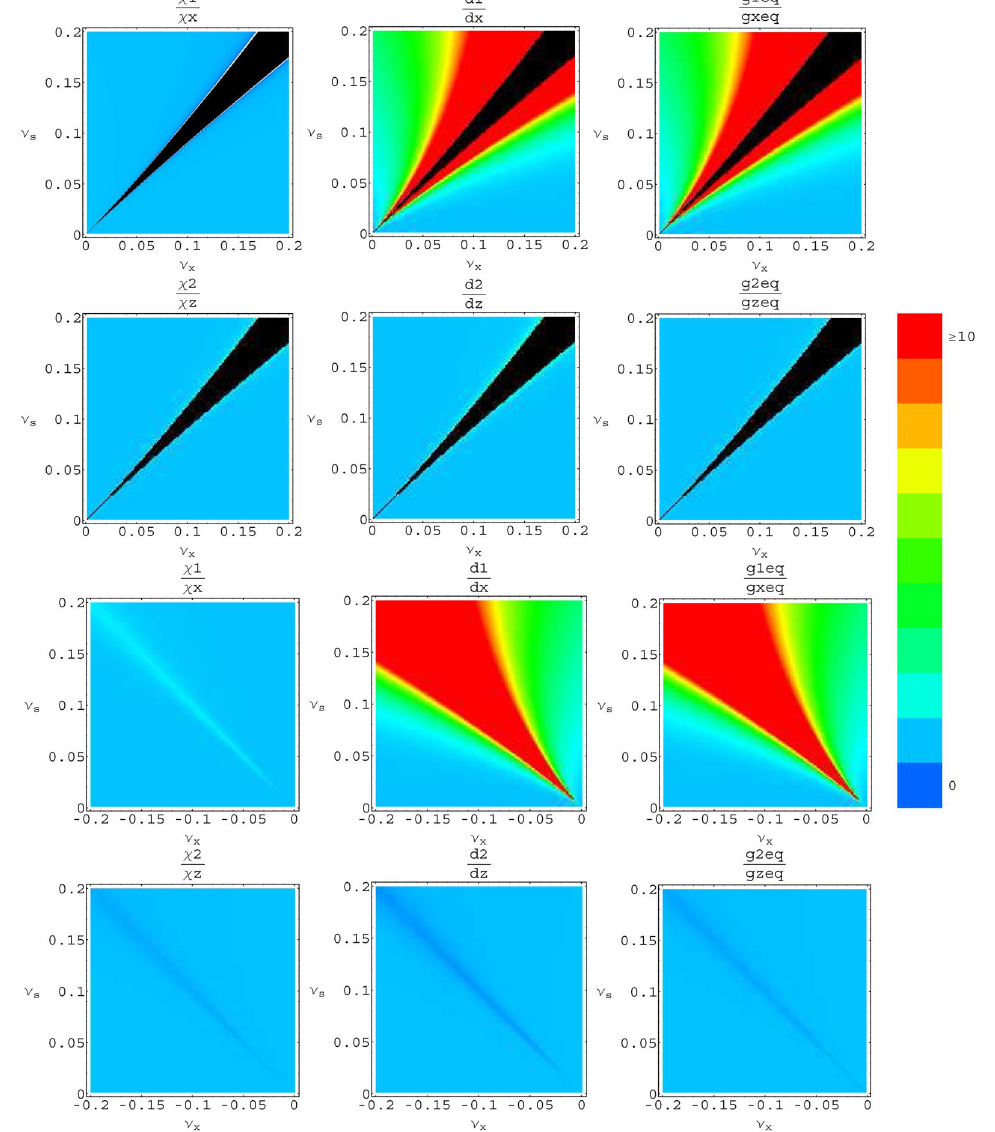
FIG. 1. (Color) In this figure, we plot global damping, diffusion, and equilibrium invariant values for coupling due to a dispersion of 1 m at an rf cavity near the sum/difference resonances. The upper two rows are the sum resonance, and lower two are the difference resonance. The parameters are otherwise drawn from Table VI based on the PEP-II LER. The quantities are plotted as a function of the and the synchrotron tune (cid:7) which is positive and equal to (cid:1) (cid:7) , thus giving an inversion of sum and difference betatron tune (cid:7) x s z and (cid:3) are global damping decrements expressed in Table V. (cid:3) d and (cid:3) d are global diffusion coefficients expressed in resonances. (cid:3) 1 2 1 2 i i and h g are one half the ratio of these quantities as given by Eq. (47). All quantities have been divided by their Table IV, and h g 1 eq 2 eq uncoupled values so that the blue region with the value of 1 represents no effect from coupling. The region of instability due to the Hamiltonian dynamics is black. There is also an extremely small region of antidamping instability outside the symplectic instability is negative. This region is indicated by region for the sum resonance where the damping decrement (cid:3) 1